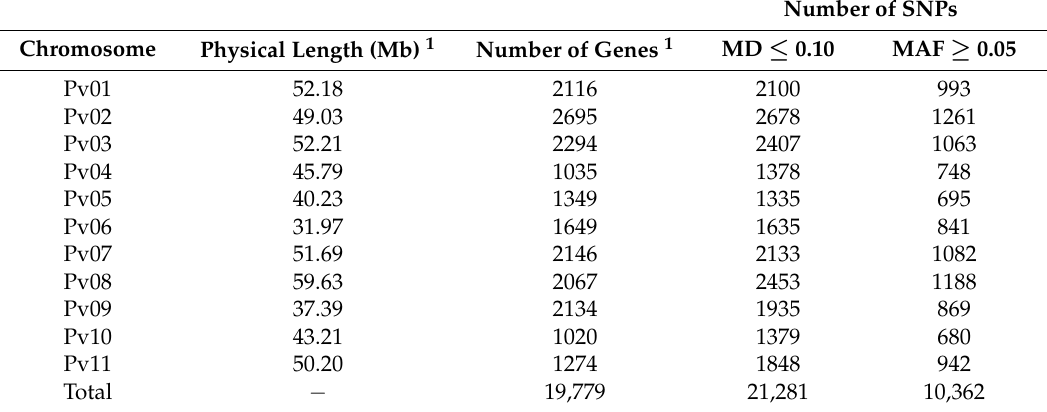
Table 1. Number of single nucleotide polymorphisms (SNPs) per chromosome of Phaseolus vulgaris generated by Ape KI-GBS (genotyping by sequencing) technology in the IAC (Agronomic Institute) diversity panel.